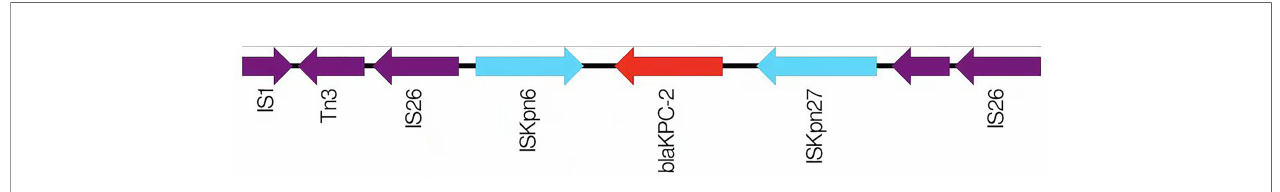
FIGURE 5 | A schematic diagram of the genetic structure surrounding bla KPC-2 . The direction of the arrow represents the direction of transcription.